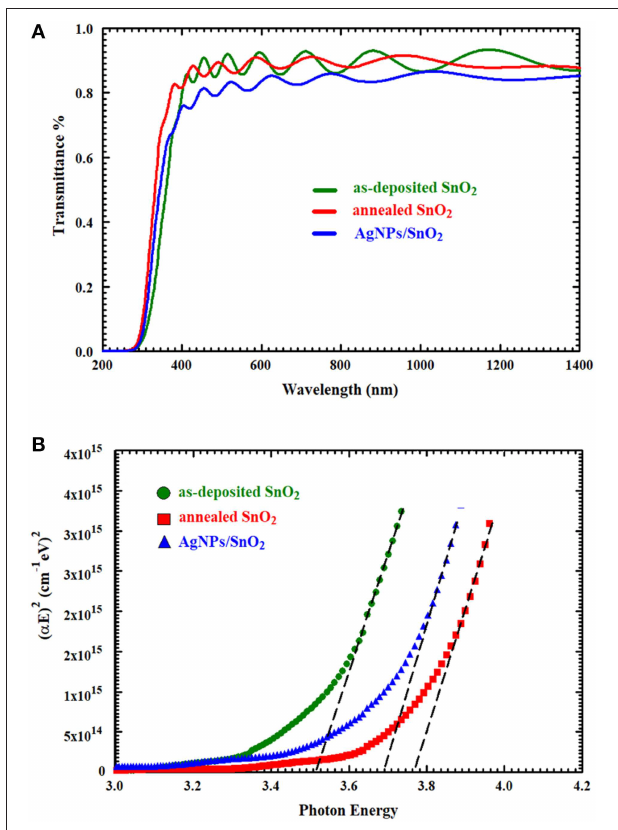
FIGURE 4 | (A) The UV–Vis transmittance spectra of as-deposited SnO 2 , annealed SnO 2 , and AgNPs/ SnO 2 films. (B) Optical band gap of as-deposited SnO 2 , annealed SnO 2 , and AgNPs/SnO 2